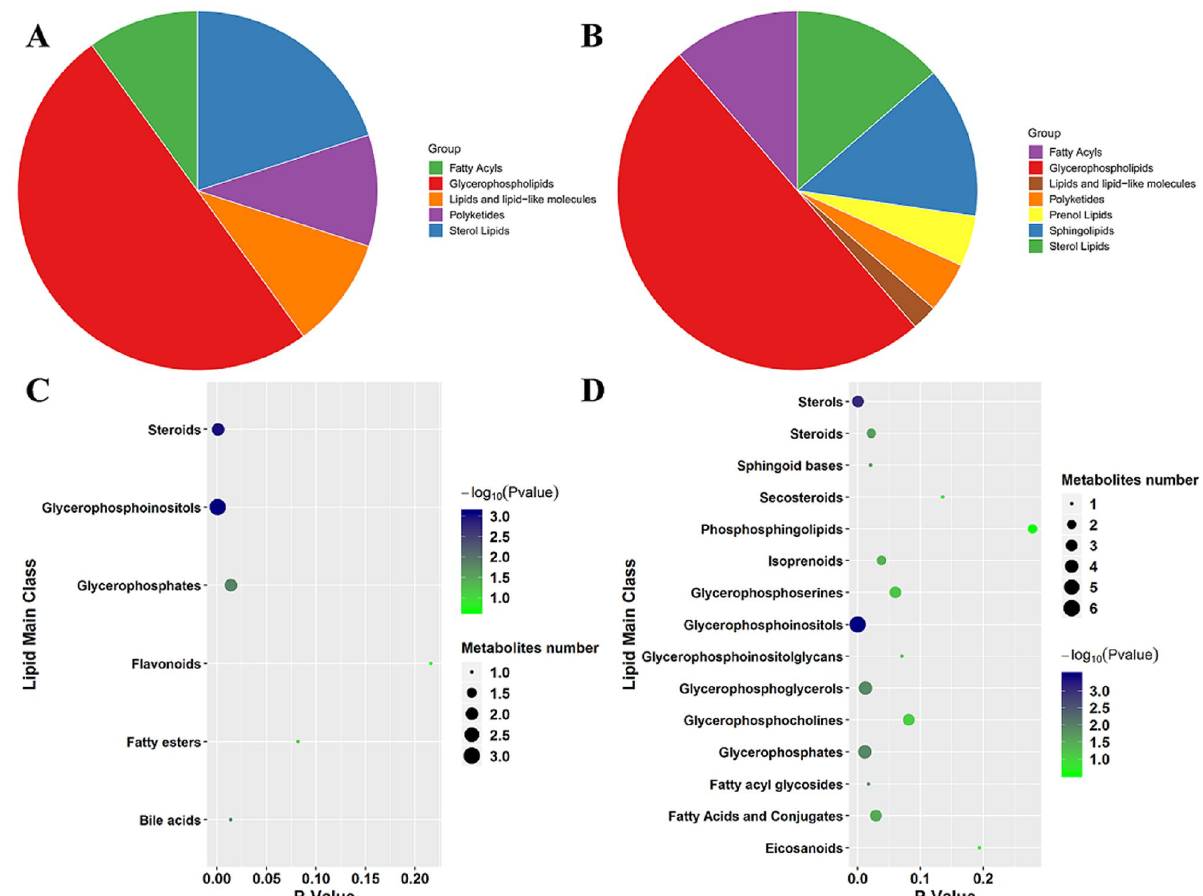
Figure 4. Classification of MTB- and MB-induced lipids. ( A , B ) The pie chart represents the main lipid super- classes associated with MTB- ( B ) and MB-infection ( A ). The area represents the percentage of each class. ( C , D ) Lipid main class enrichment analysis under MTB ( B ) and MB ( A ) attacks, respectively. The size of circle represents the lipid number in the enriched categories (P <